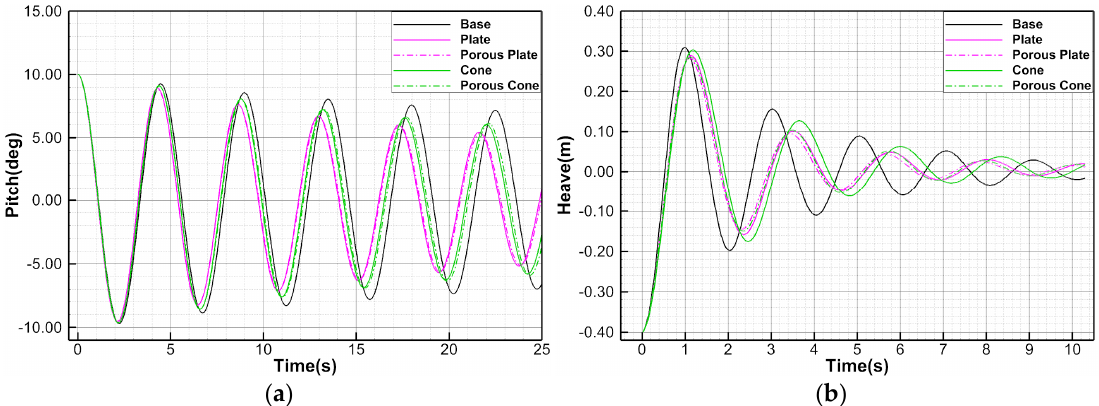
Figure 10. Free pitch ( a ) and ( b ) heave decay curves of the lightweight light buoys.